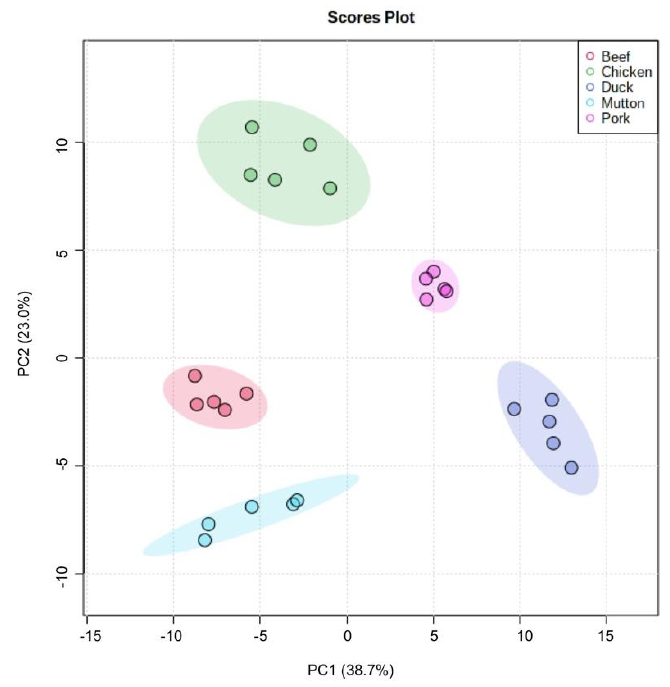
Figure 4. PCA plot according to the volatiles’ profiling in five different meats.